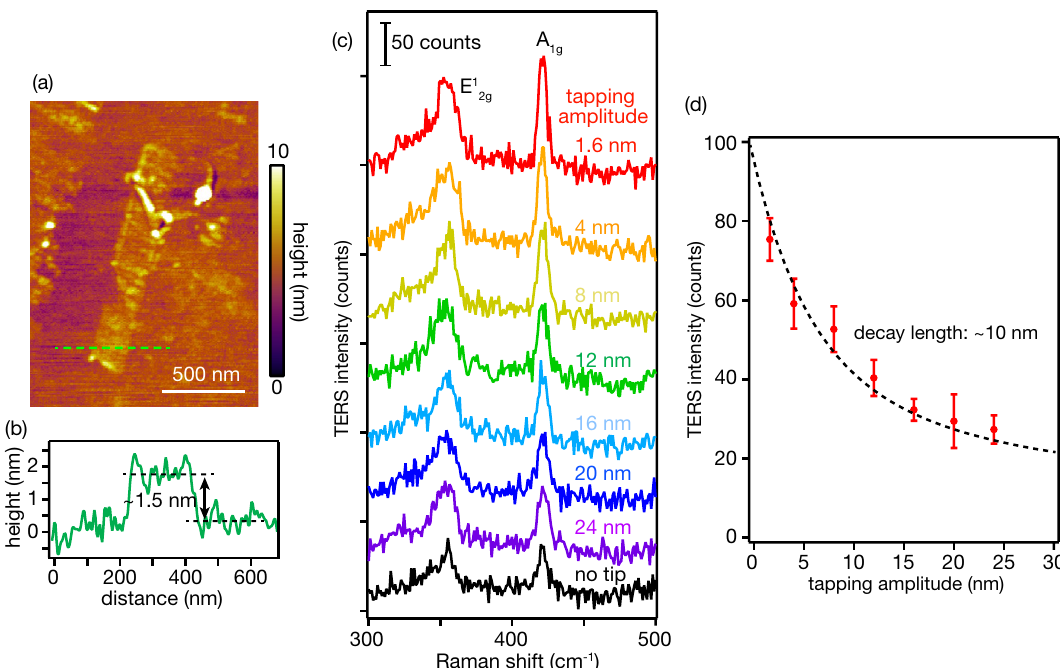
Figure 5. ( a ) AFM image of a bilayer WS 2 ( b ) Topographic line-profile obtained from the green dotted line in (a). ( c ) TERS spectra of WS 2 obtained at different tapping amplitudes. The black curve shows the far-field Raman spectrum obtained without a tip. ( d ) Dependence of TERS intensity of A 1g mode on the tapping